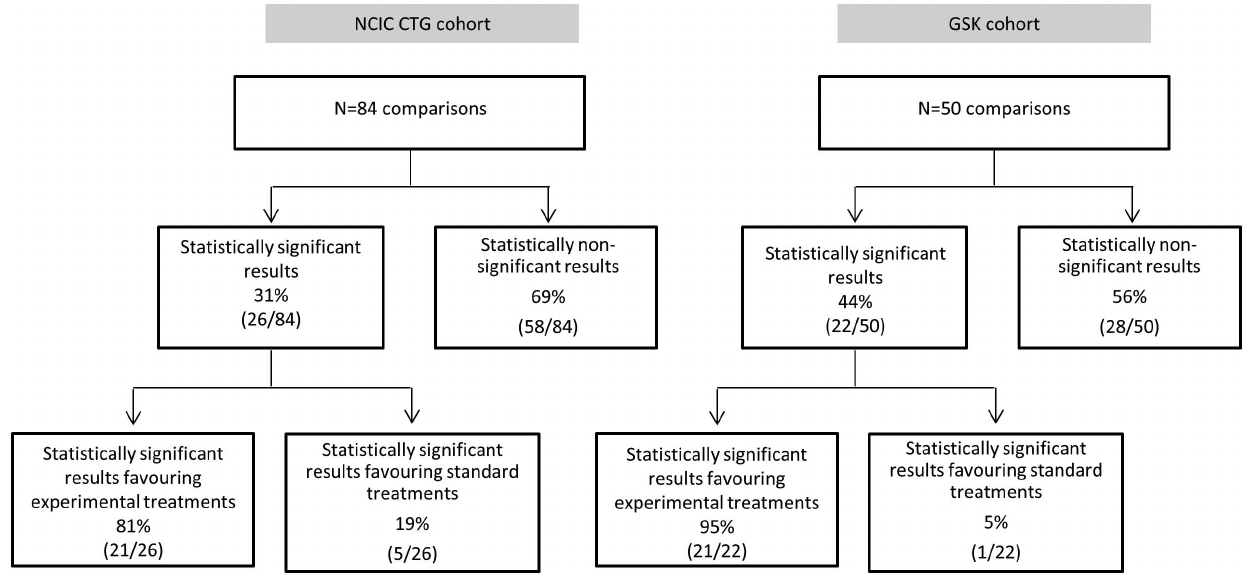
Figure 3. Distribution of success rate according to the results being statistically significant versus non-significant for the a priori specified primary outcome.